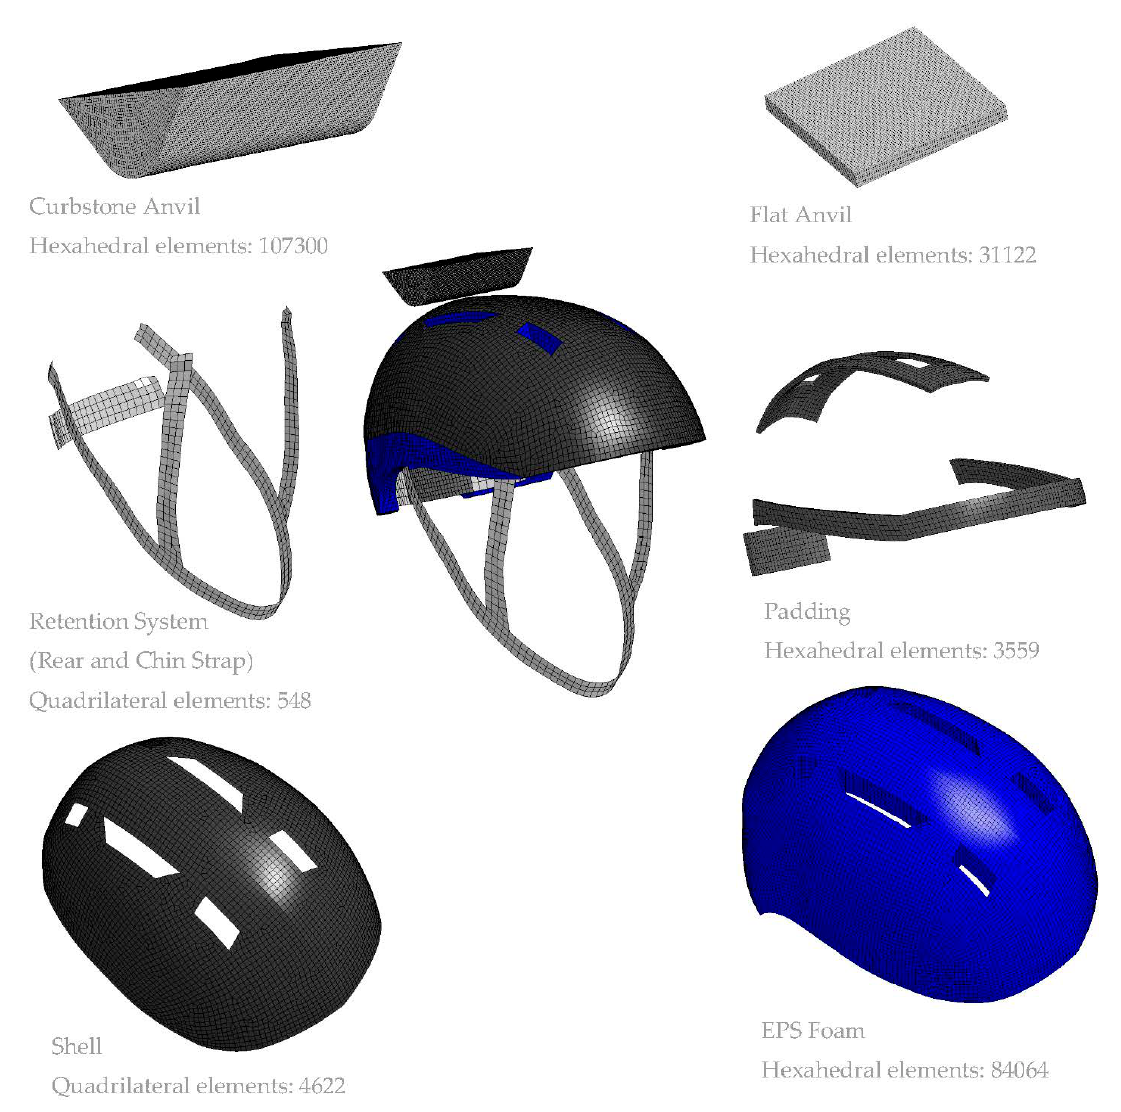
Figure 1. Helmet mesh. Table 3. Material properties of helmet.